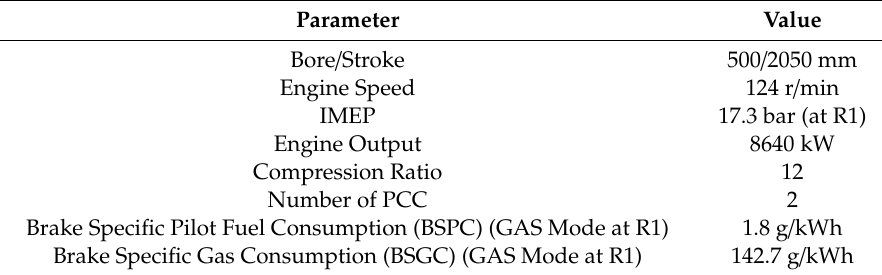
Table 1. Winterthur Gas and Diesel (WinGD) 6RT-Flex50DF engine